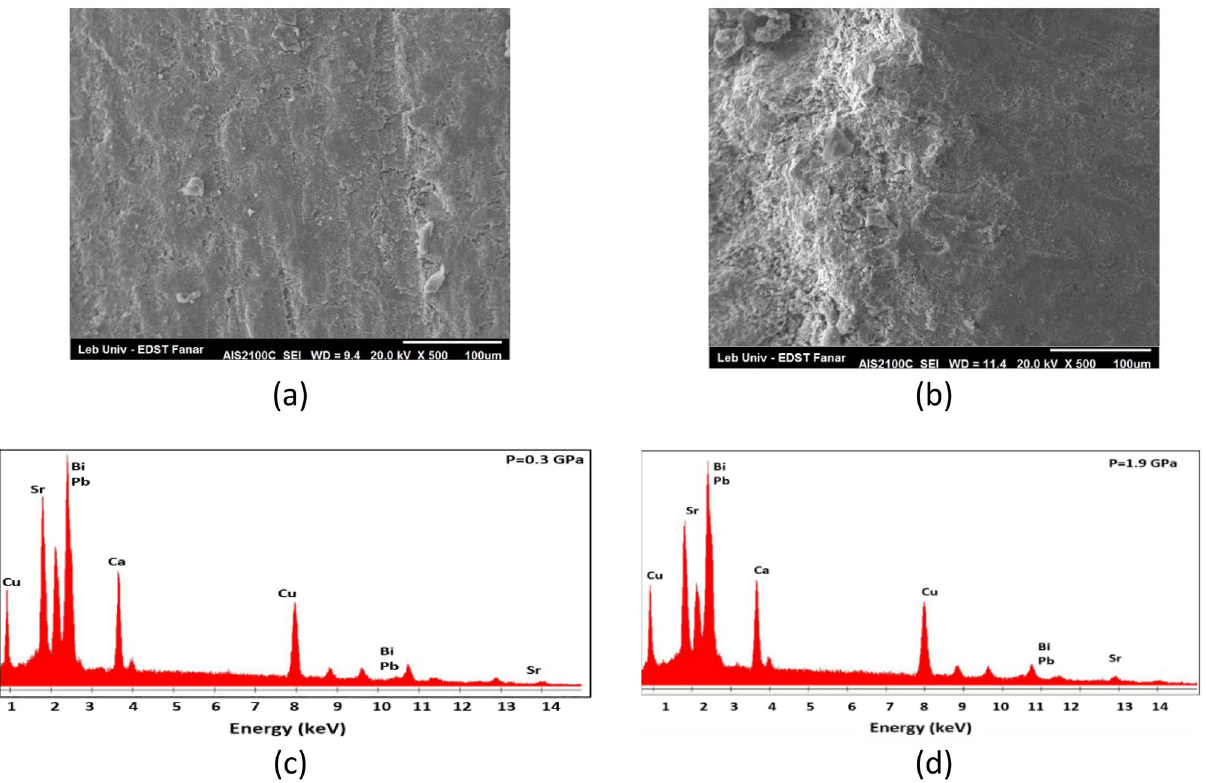
Figure 1. SEM ( a and b ) and EDX analysis ( c and d ) of (Bi, Pb)-2223 superconductor compacted at P = 0.3 and 1.9 GPa,